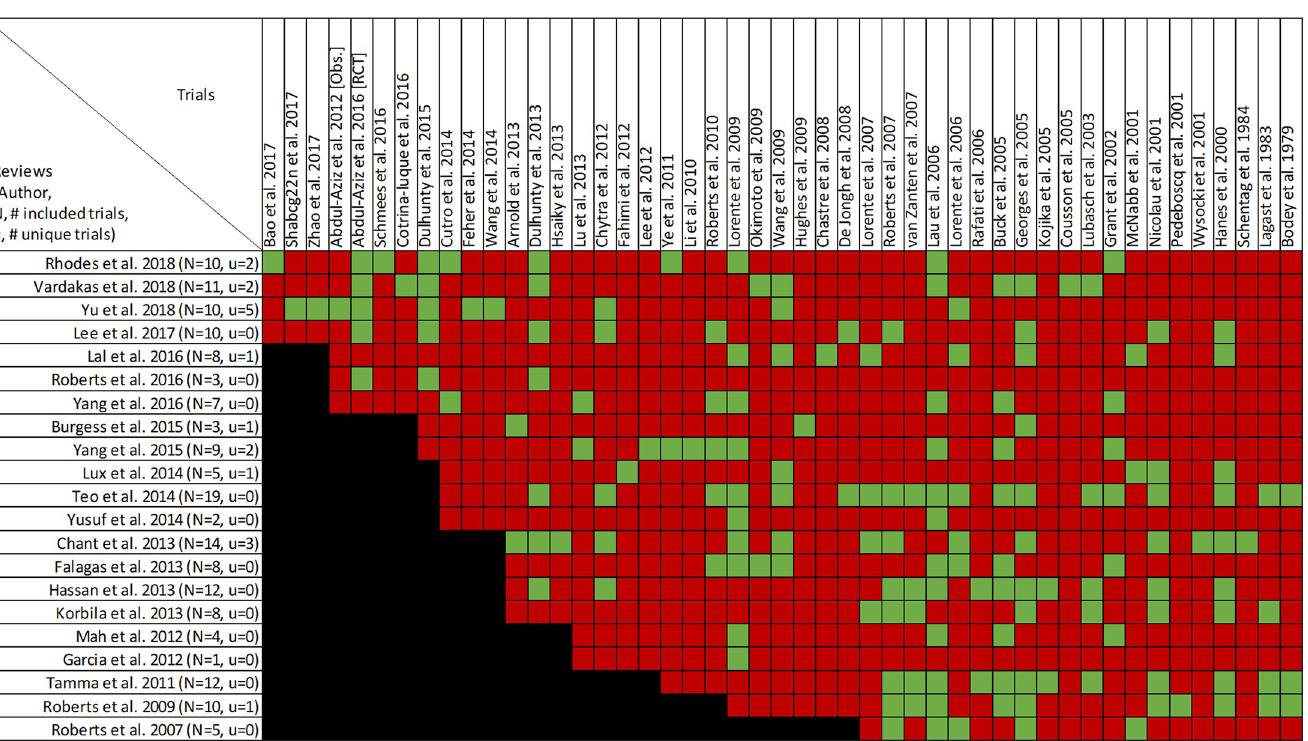
Fig 6. Citation matrix for reviews reporting clinical cure of prolonged infusions versus intermittent infusions of beta-lactams. Green—primary studies included in systematic review, Red—primary study not included in systematic review, Black—primary studies published after systematic review and therefore ineligible for possible